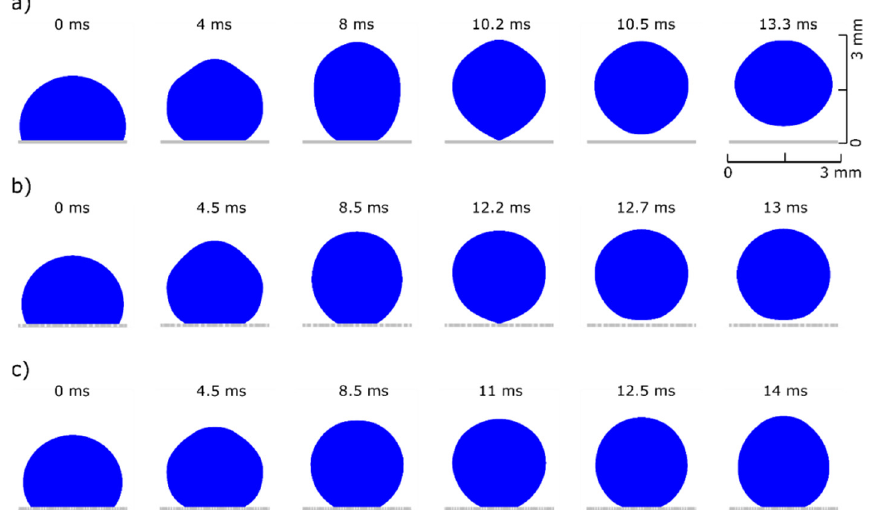
Figure 5. Water droplet dynamics in air medium over different topographies. ( a ) perfectly smooth surface where the droplet detaches at a time of 10.2 ms and the center of mass reaches at a maximum height of 1.49 mm (see Video S1 of the supplementary material), ( b ) surface with axisymmetric stripes of h = 85 µ m, w = 15 µ m, and where the droplet detaches at a later time of 12.2 ms and the center of mass reaches a smaller maximum height of 1.28 mm (see Video S2) and ( c ) surface with axisymmetric stripes of h = 75 µ m, w = 20 µ m, d = 5 µ m and r = 10 µ m where no detachment occurs (see Video